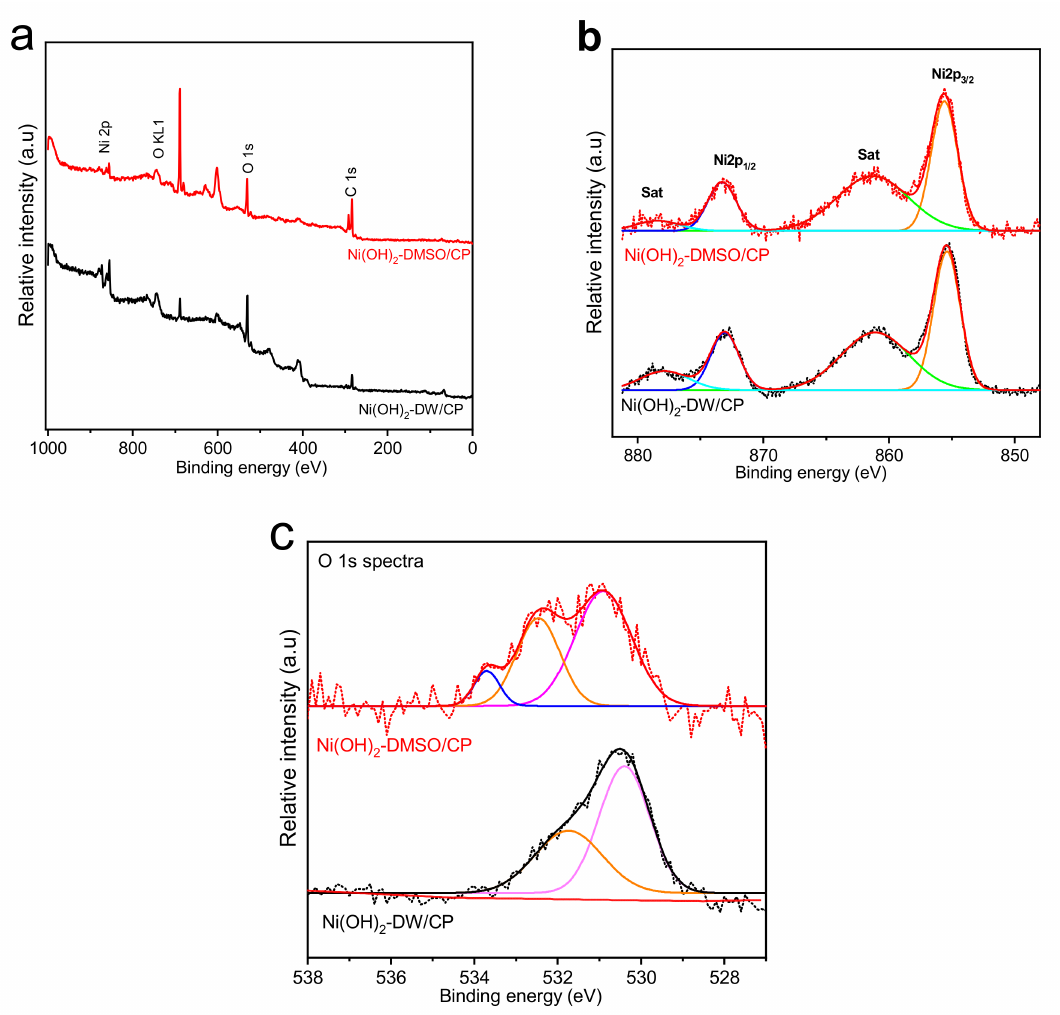
Figure 3. XPS spectra of ( a ) wide spectrum for Ni electrodeposits from all electrolytes, ( b ) Ni 2p spectra for Ni electrodeposits from both H 2 O and DMSO solutions, and ( c ) O 1s for the prepared catalyst from the DMSO electrolyte after electrodeposition and electrochemical